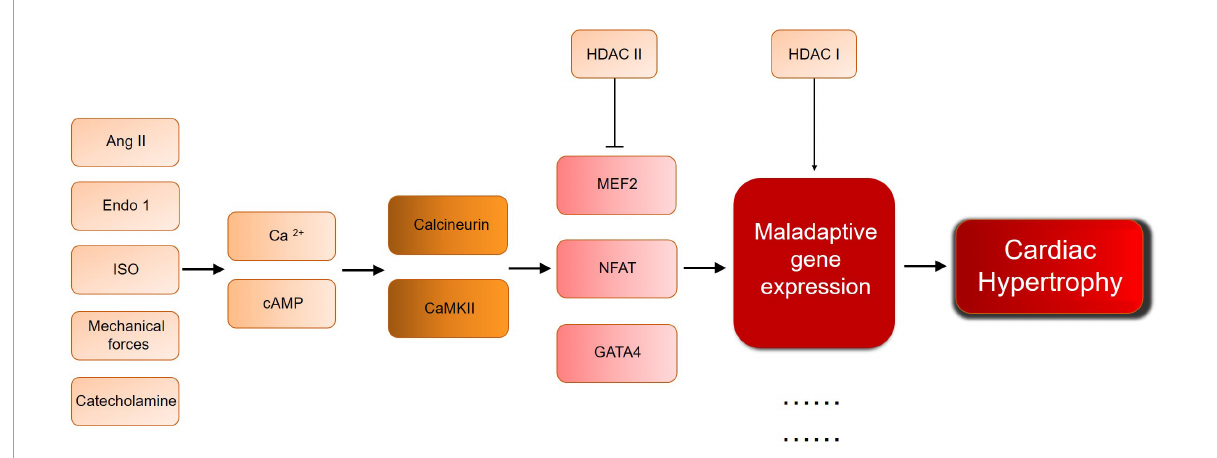
FIGURE2 A brief scheme of cardiac hypertrophy development and the key molecules mentioned in this review. Ang II, angiotensin II; Ca, calcium; CaMKII, calcium/calmodulin dependent protein kinase; Endo 1, Endothelin 1; GATA, GATA binding protein; HDAC, histone deacetylase; ISO, isoproterenol; MEF, myocyte-specific enhancer factor; NFAT, nuclear factor of activated T cells.